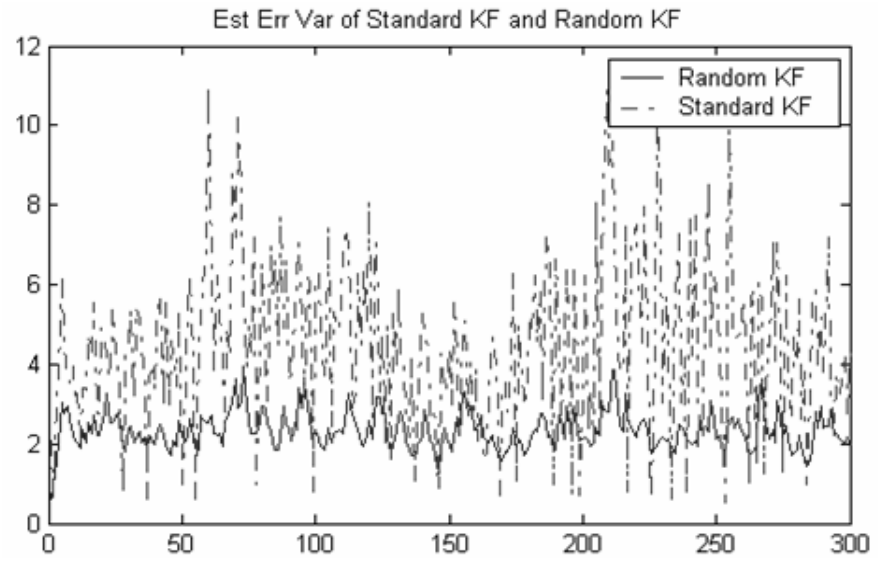
Figure 1. Comparison of standard Kalman filtering fusion and random Kalman filtering